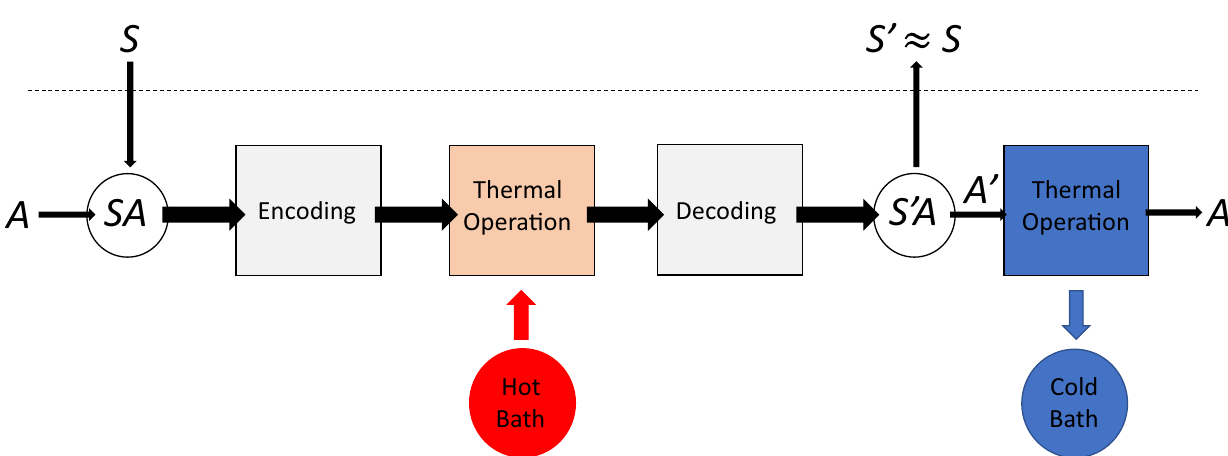
FIG. 1. A diagrammatic representation of QEC as a heat engine with a feedback controller, with the time flow going from left to right). From the left, we have the encoding of the system S using the ancillary system A for redundancy. Next, the encoded system SA interacts with a hot bath of temperature T h (representing the noisy channel), followed by a decoding stage, where the errors in SA are detected and an attempt to correct them is made via a unitary feedback process. Finally, the ancillary system is returned (recycled) to its original state with the help of a cold bath of temperature T c , in preparation for a future